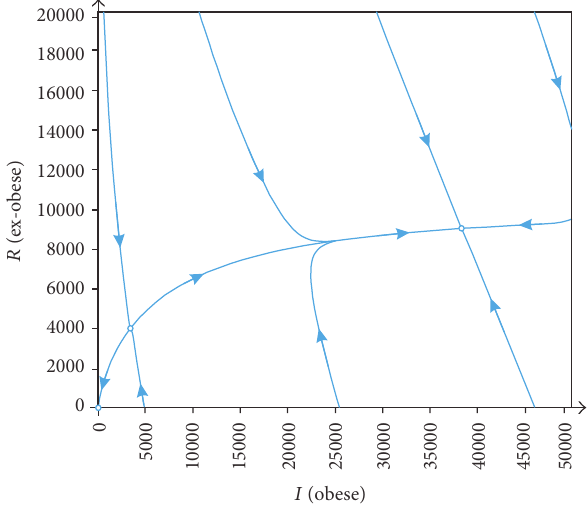
Figure 8: Phase portrait of system (6) (case 𝜖 = 0 ), for the value = 1 obtained by considering 𝛽 = 4.23 × 10 −7 . 𝑅 0